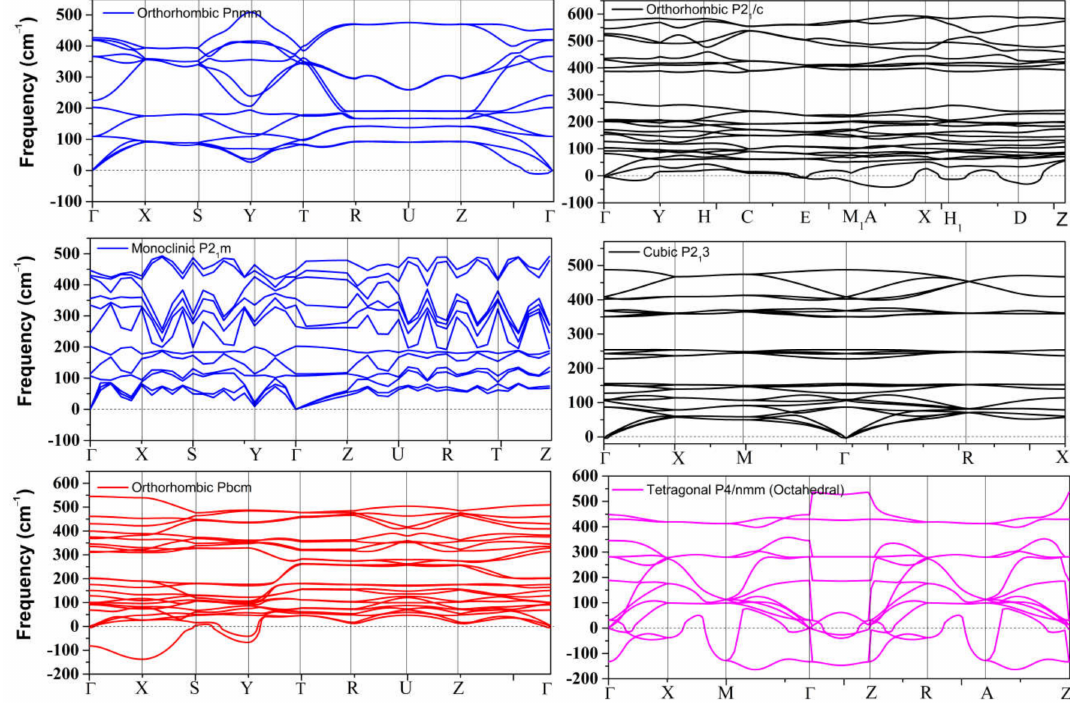
Figure 1. Phonon dispersion of all metastable phases for SnO at 0